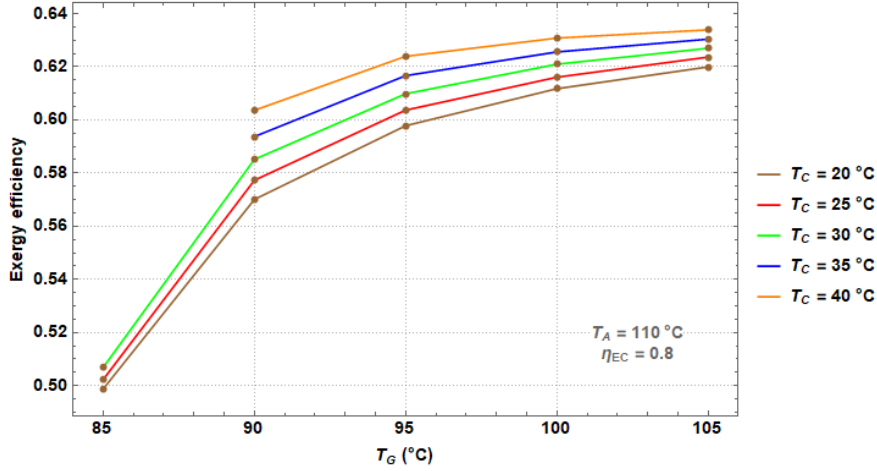
Figure 9. Exergy as a function of the T G for different T C values for the DEHT.